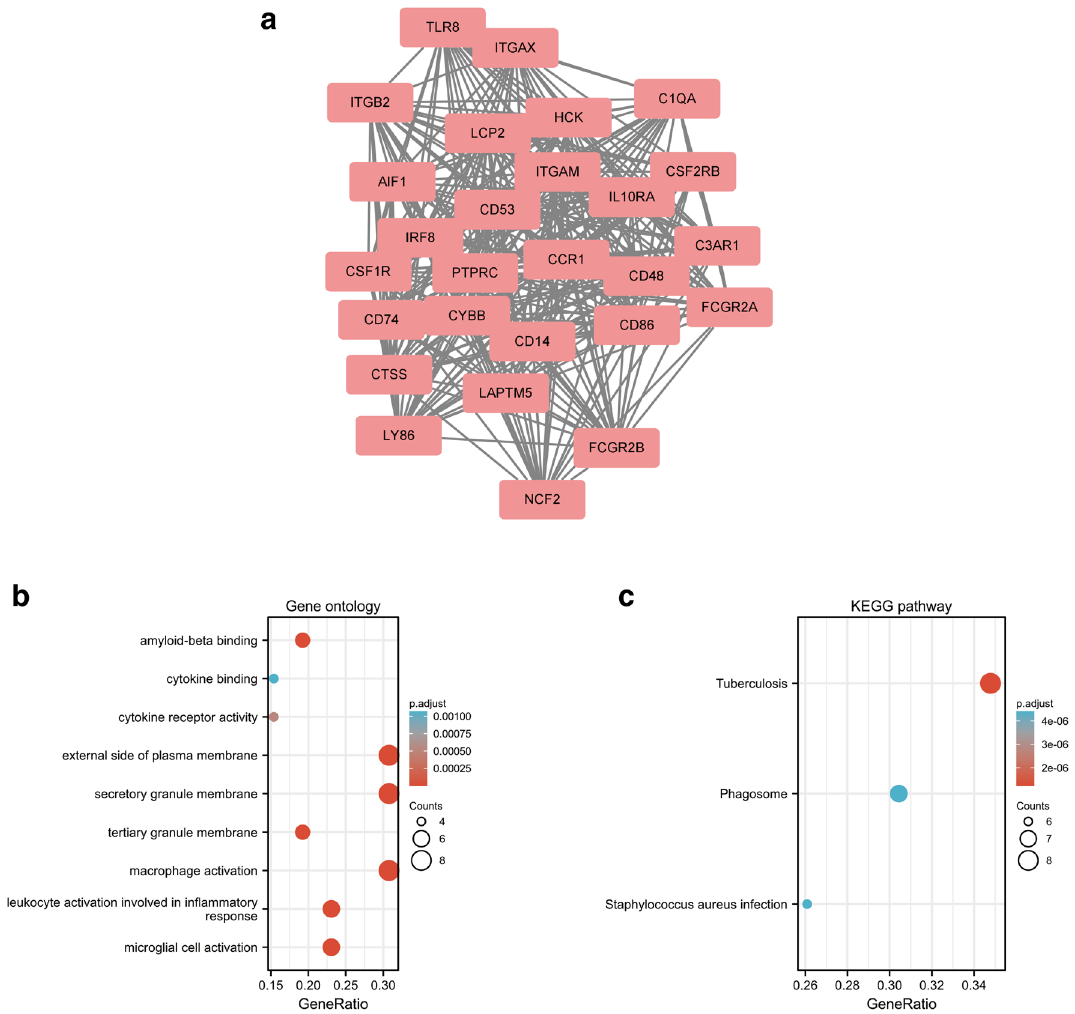
Figure 2. Cluster modules extracted by MCODE and enrichment analysis of the modular genes. ( a ) One significant gene clustering module. ( b ) GO and ( c ) KEGG enrichment analysis of the modular genes. Adjusted P value < 0.05 was considered